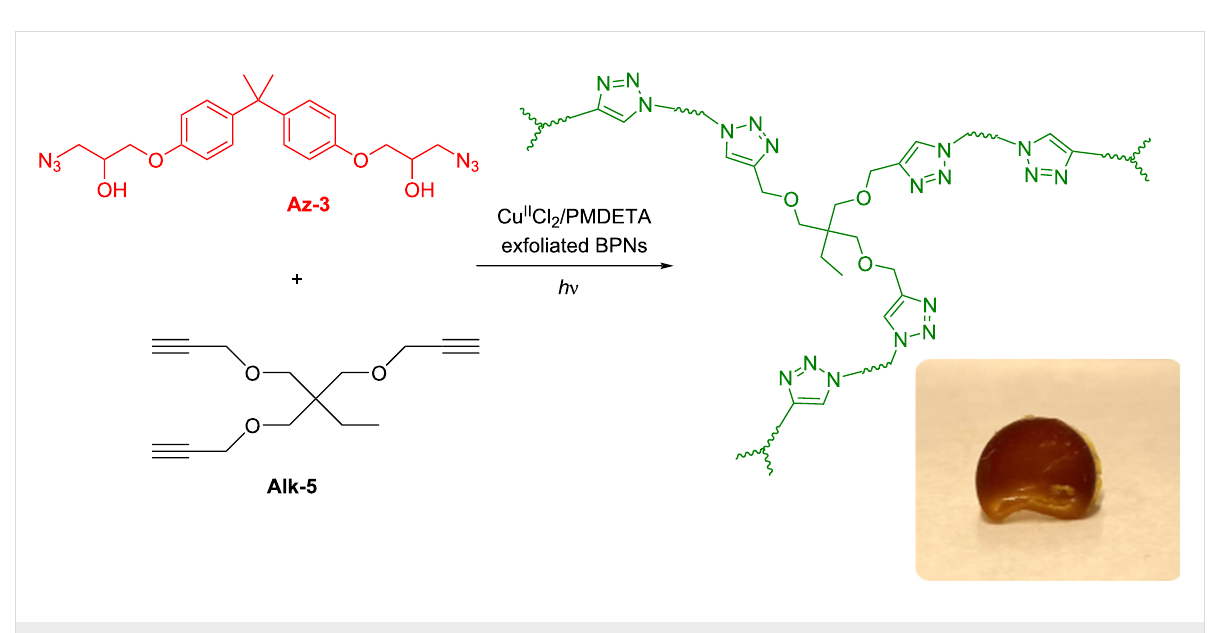
Scheme 3: Preparation of the cross-linked polymer by CuAAC reaction using multifunctional monomers, Az-3 and Alk-5 .